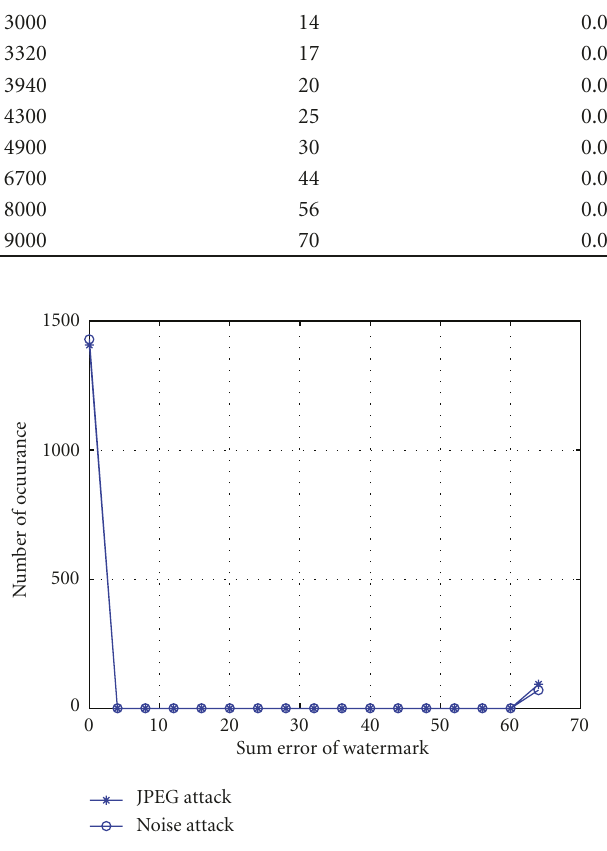
Figure 8: The robustness of watermark to incidental manipula- tions.